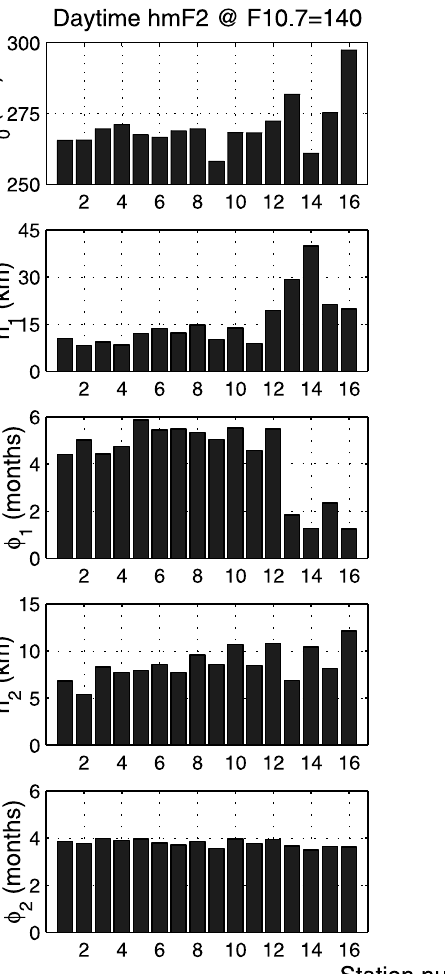
Fig. 6. Day and night values of annual mean h mF2 ( h ) and the amplitude and 0 phase of the annual component ( h , / ) and 1 1 semiannual component ( h , / ) for day (10– 2 2 14 LT) and night (22–02 LT), solar 10.7 flux 140 units. The stations are arranged in north -to- south order of magnetic latitude ( 1 , Kiruna, 2 , Loparskaya, 3 , Sodankyla¨ , 4 , Lycksele, 5 , Arkhangelsk, 6 , Uppsala, 7 , Leningrad, 8 , Juliusruh, 9 , Slough, 10 , Moscow, 11 , Wallops Is, 12 , Wakkanai, 13 , Norfolk Is, 14 , Port Stanley, 15 , Mun- daring, 16